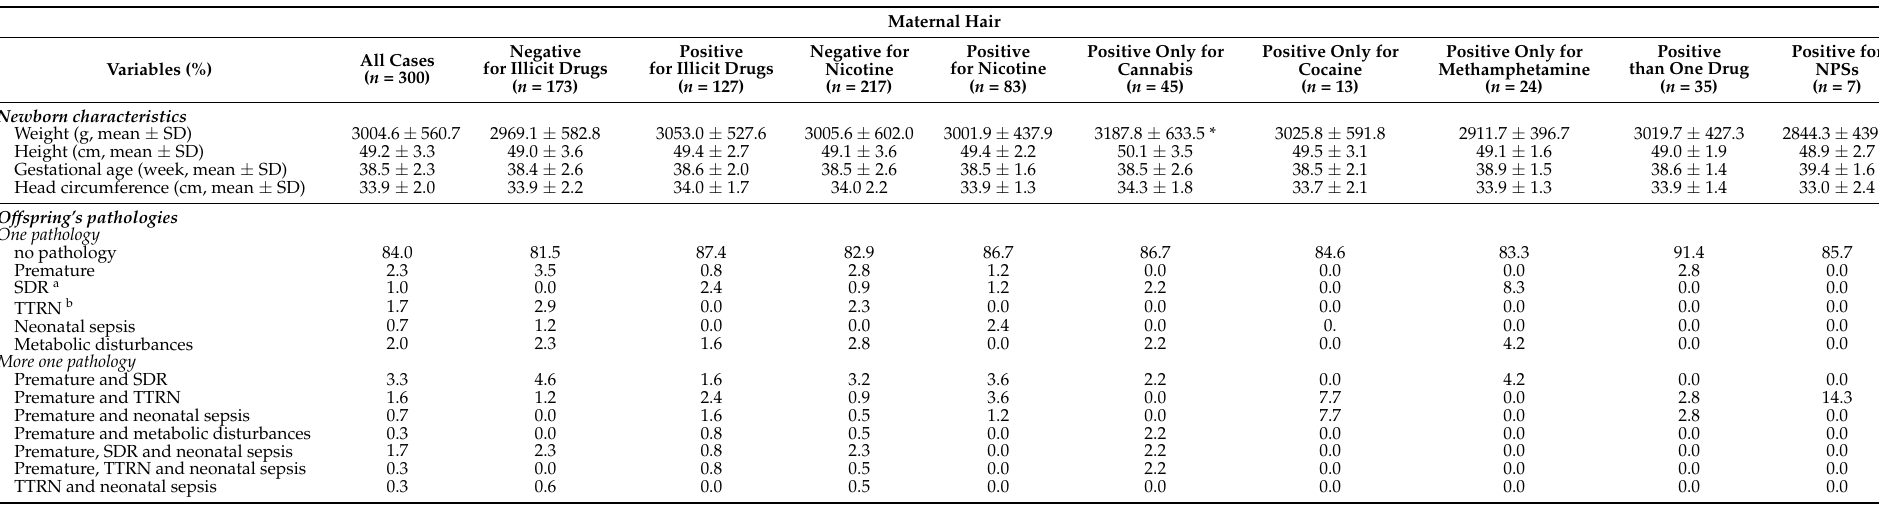
Table 6. Newborn profiles associated with negative and positive illicit drugs and tobacco biomarkers detected in women